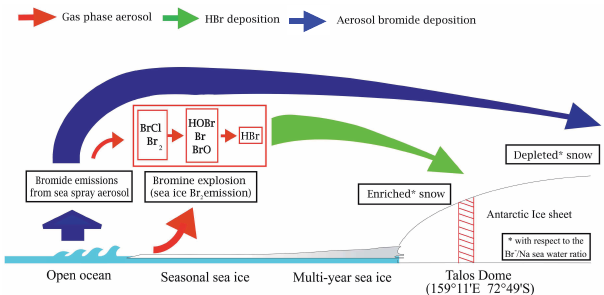
Fig. 5. Simplified scheme for bromide aerosol deposition in coastal Antarctica. Blue lines indicate the aerosol phase while red lines in- dicate the gas phase. Green line the HBr